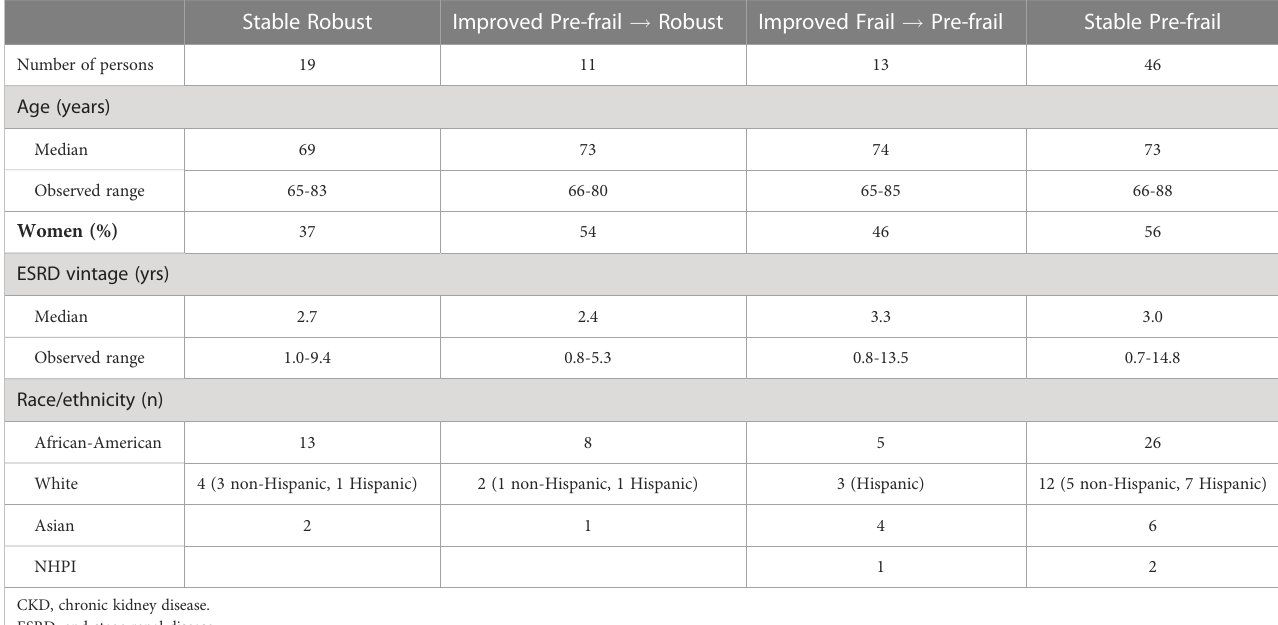
TABLE 4 Participants with stable robust, improved, and stable pre-frail status as of their 24-month follow-up: Characteristics of older persons with dialysis-dependent CKD. Stable Robust